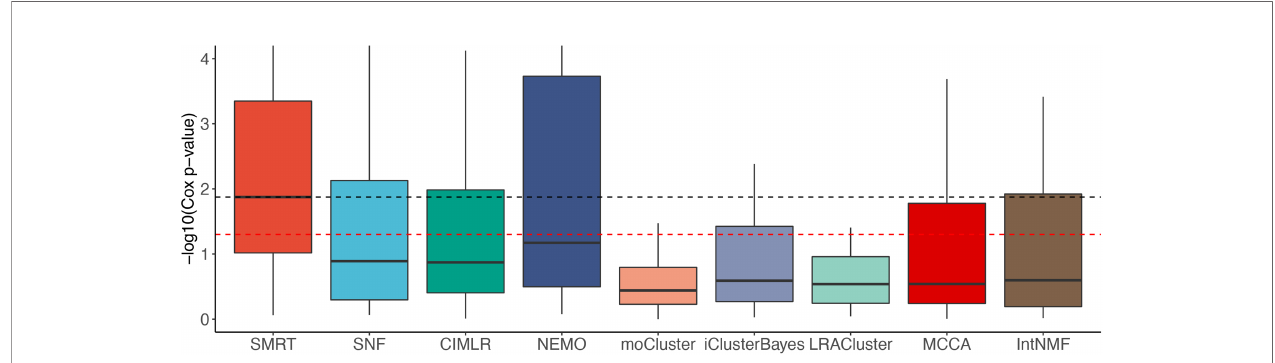
FIGURE 2 | Distributions of Cox p-values (in – log 10 scale, higher is better) of the subtypes discovered from 37 TCGA and 2 METABRIC datasets. The red dashed line shows the 5% signi fi cance level. Note that all existing methods do not reach this level of signi fi cance on average (median). Overall, the Cox p-values obtained from SMRT are substantially more signi fi cant than those of other methods ( p = 0.0002 using the one-tailed Wilcoxon test).